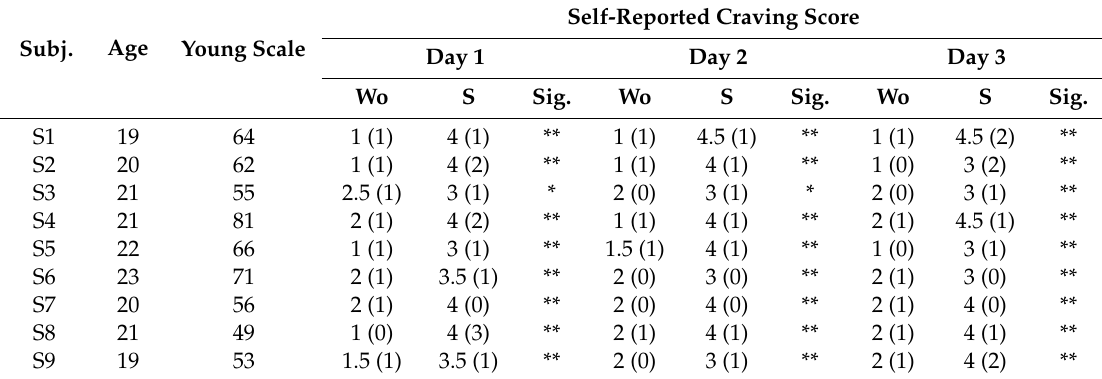
Table 1. Demographic and median (interquartile range) of self-reported craving scores of participants.